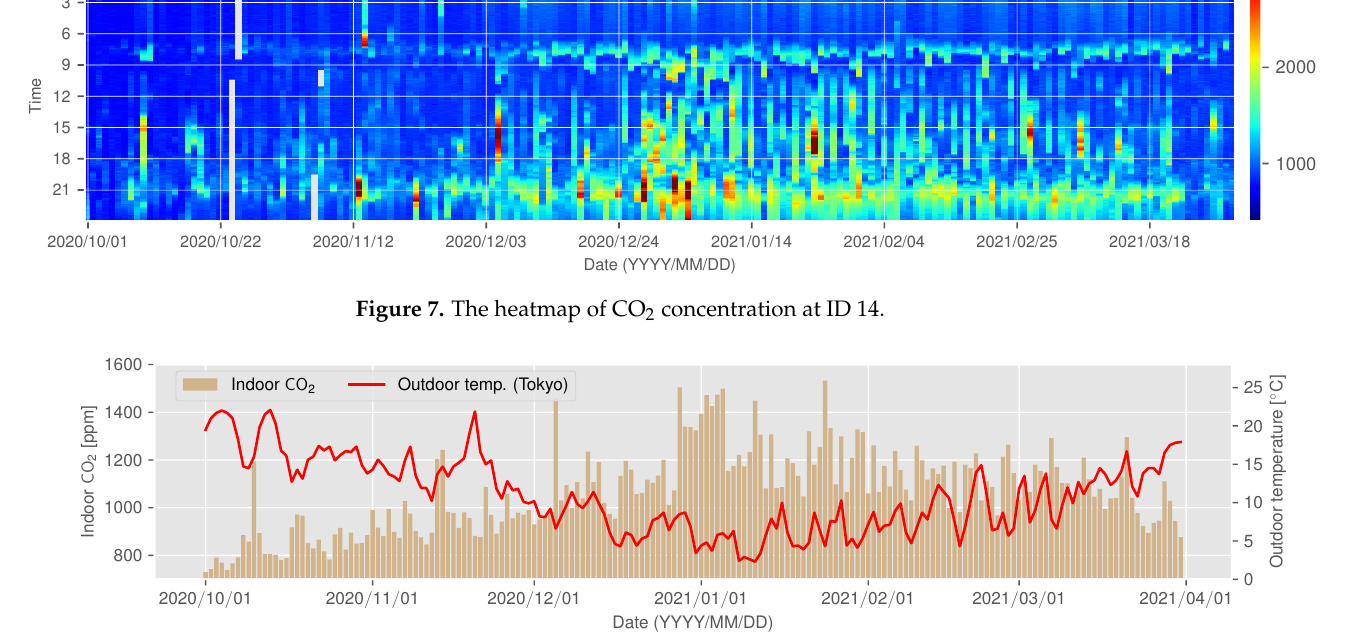
Figure 8. The changes in indoor CO 2 concentration (vertical bars) and outdoor temperature (red line) at ID 14.